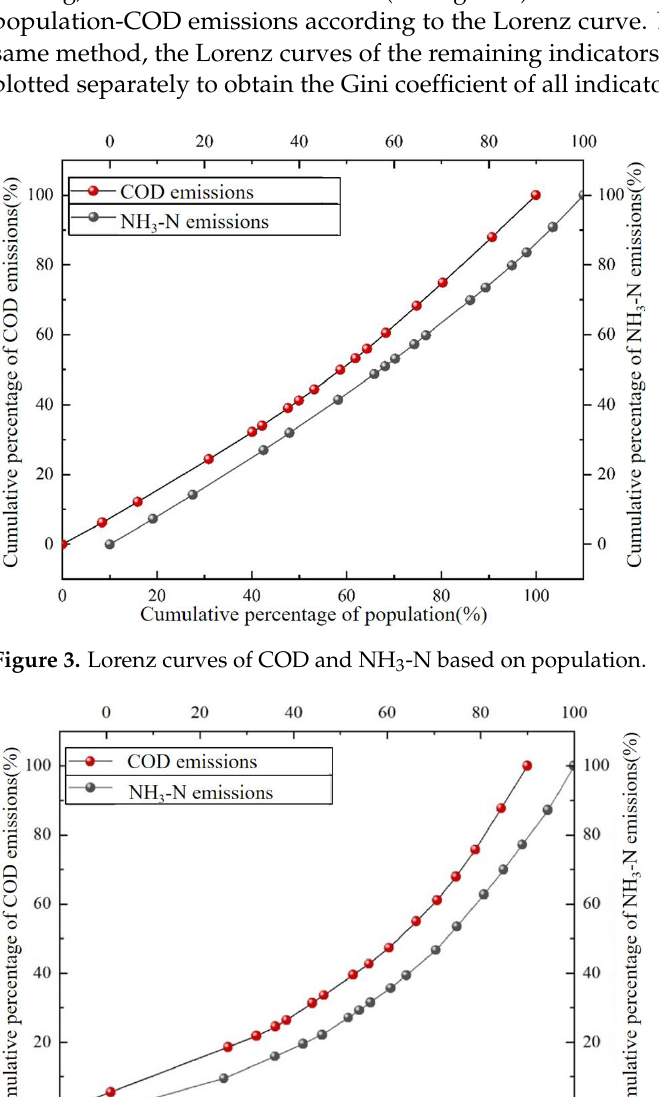
Figure 5. Lorenz curves of COD and NH 3 -N based on total water resources indicators.